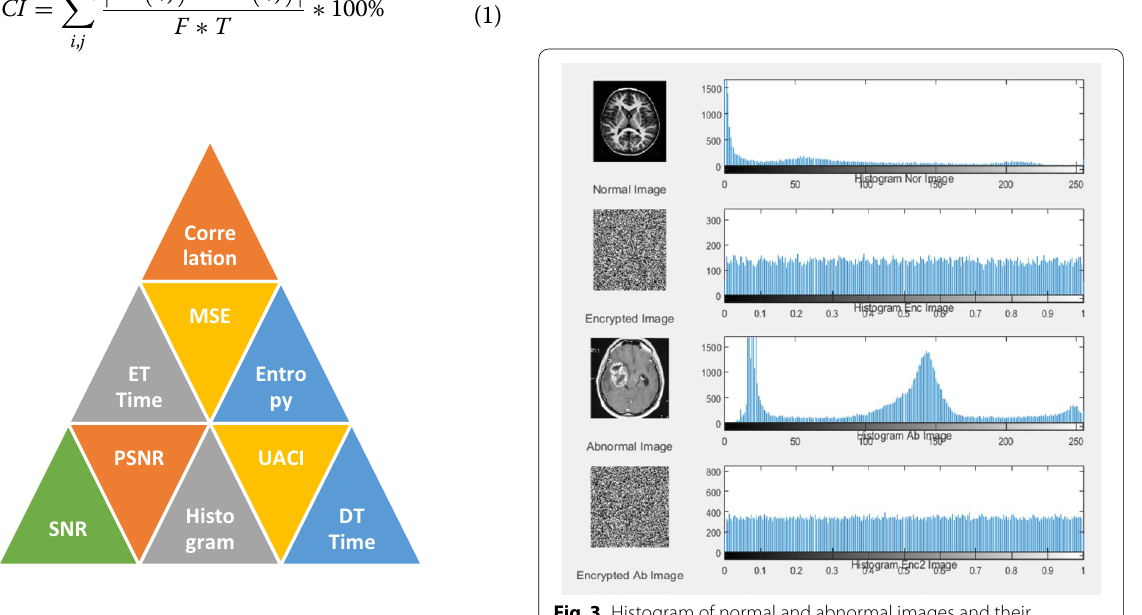
Fig. 3 Histogram of normal and abnormal images and their encryption